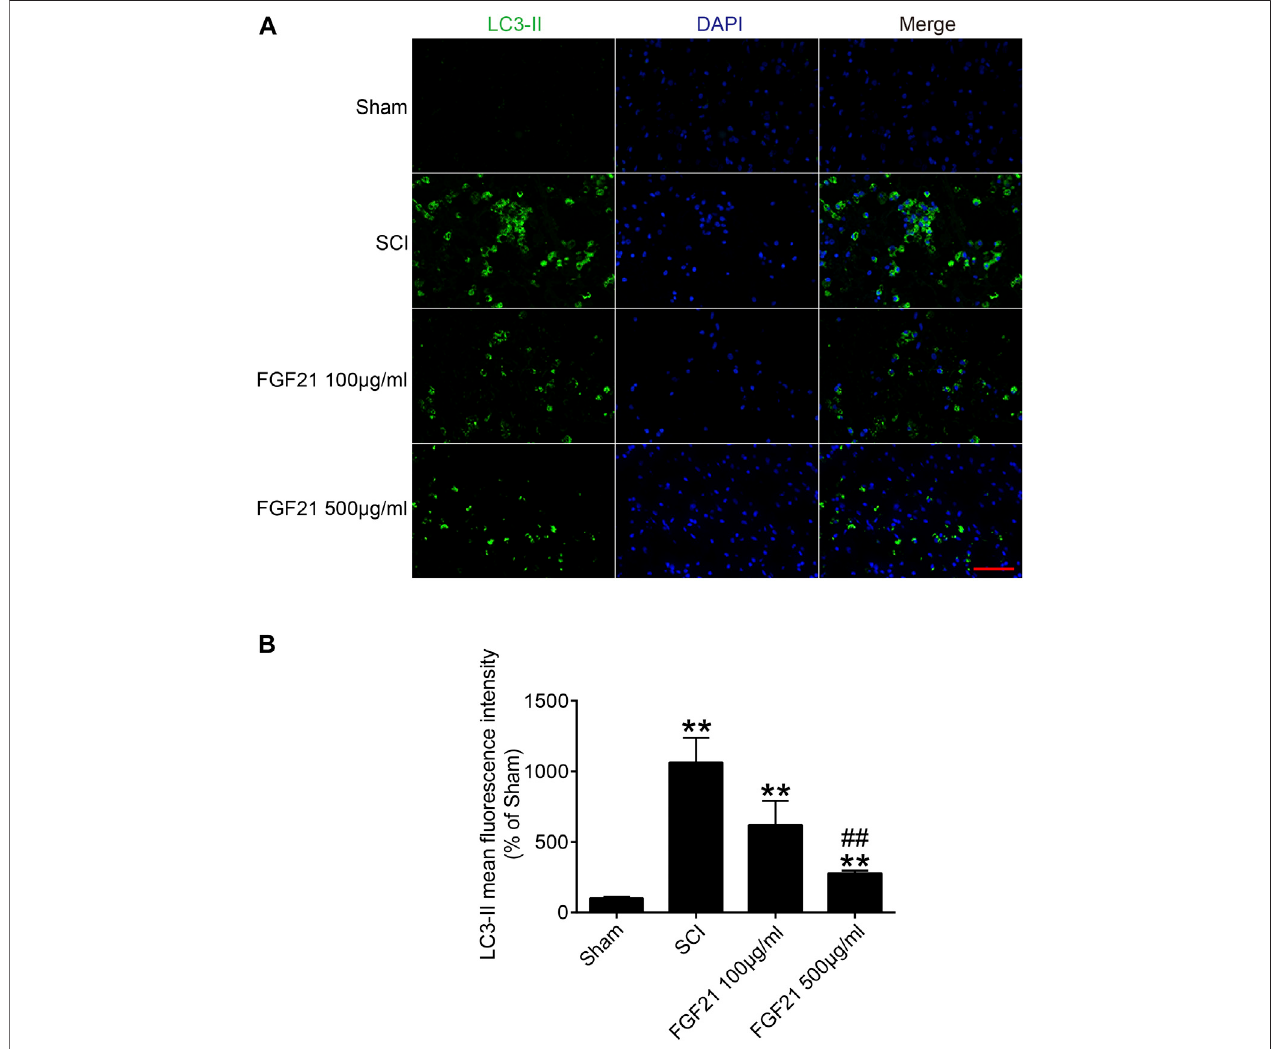
FIGURE6| FGF21administrationresultsinattenuationofSCI-inducedautophagy (A) Theimmuno fl uorescencestainingforLC3-IIinSham,SCIgroup,andFGF21 treated groups. Green fl uorescence represents LC3-II. DAPI (blue) is applied to stain nuclei. Scale bar (cid:1) 50 μ m (B) Quantitation of the Immuno fl uorescence staining results of LC3-II by mean fl uorescence intensity. Representation of data is mean values ± SEM, n (cid:1) 6, “ ** ” represent p < 0.01 vs the SCI or Sham group, “ ## ” represent p < 0.01 vs the 100 μ g/ml FGF21 group.